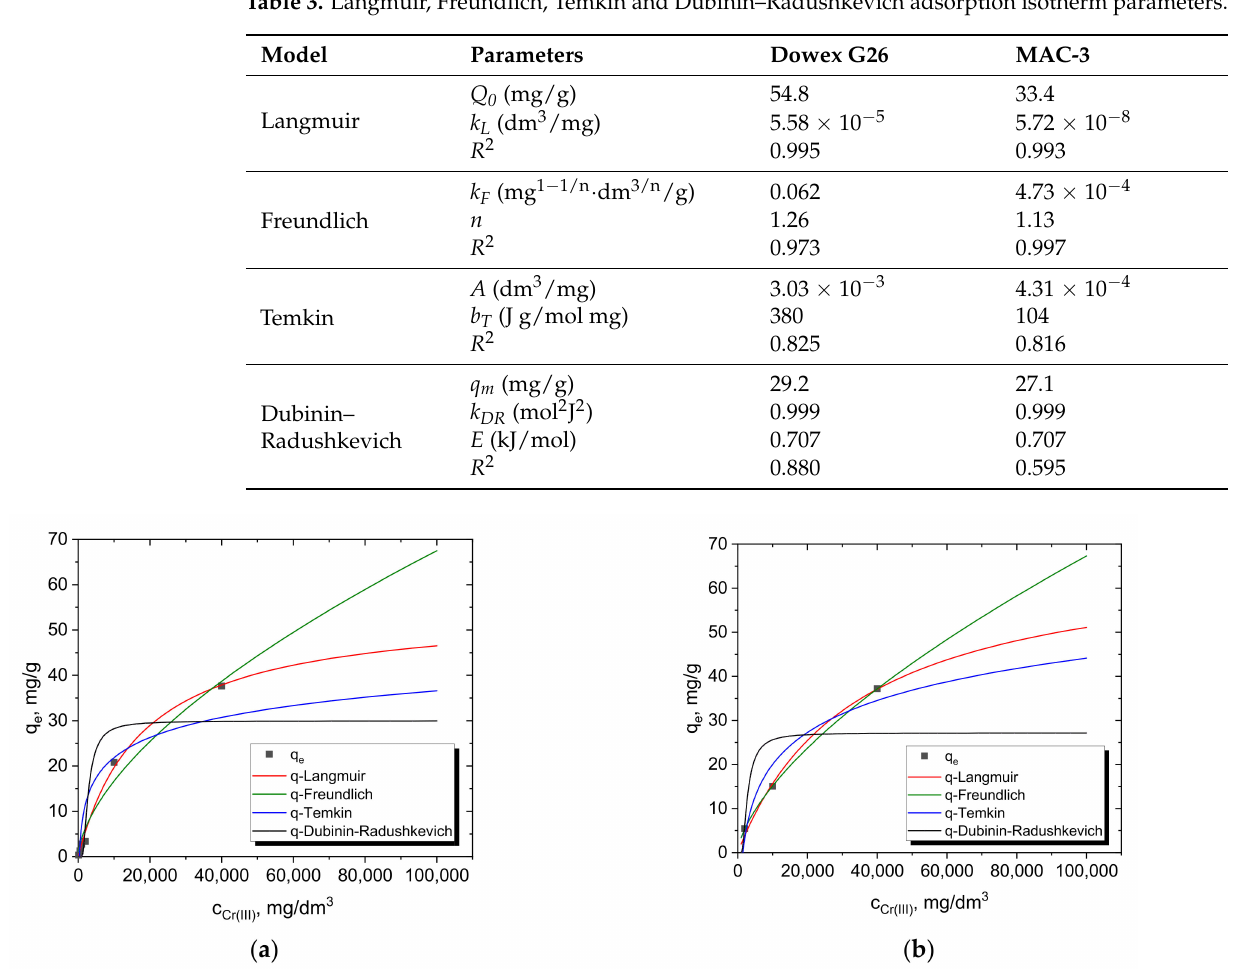
Figure 6. Fitting of Langmuir, Freundlich, Temkin and Dubinin–Radushkevich isotherms with the experimental data for the system with 500 mg of sorbents ( a ) Dowex G26; ( b )